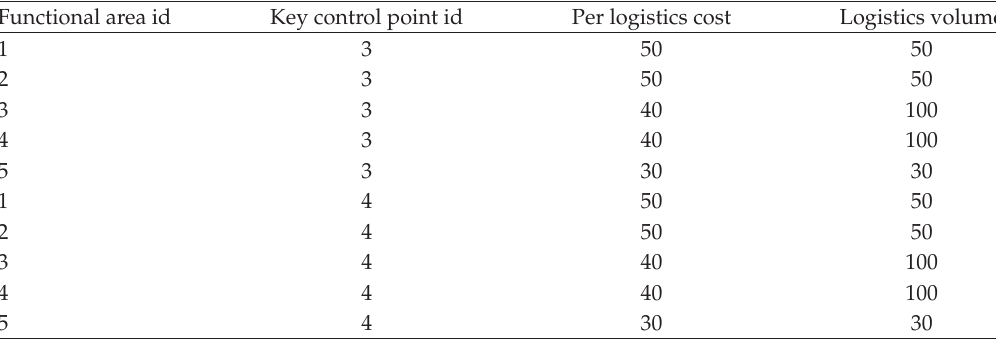
Table 5: Logistics relations table between functional area and key control